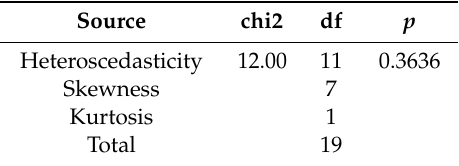
Table 4. The results of the heteroscedasticity